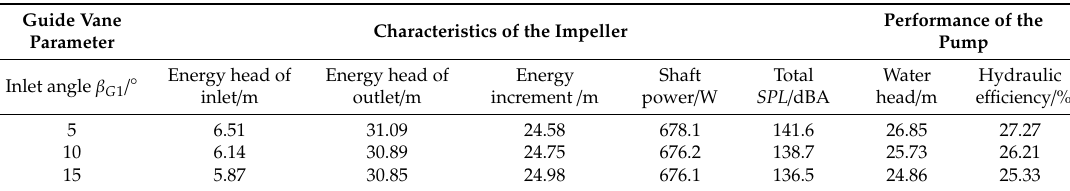
Table 8. Correlations between the inlet angle of the positive guide vane and the hydraulic and hydroacoustic characteristics of the impeller.